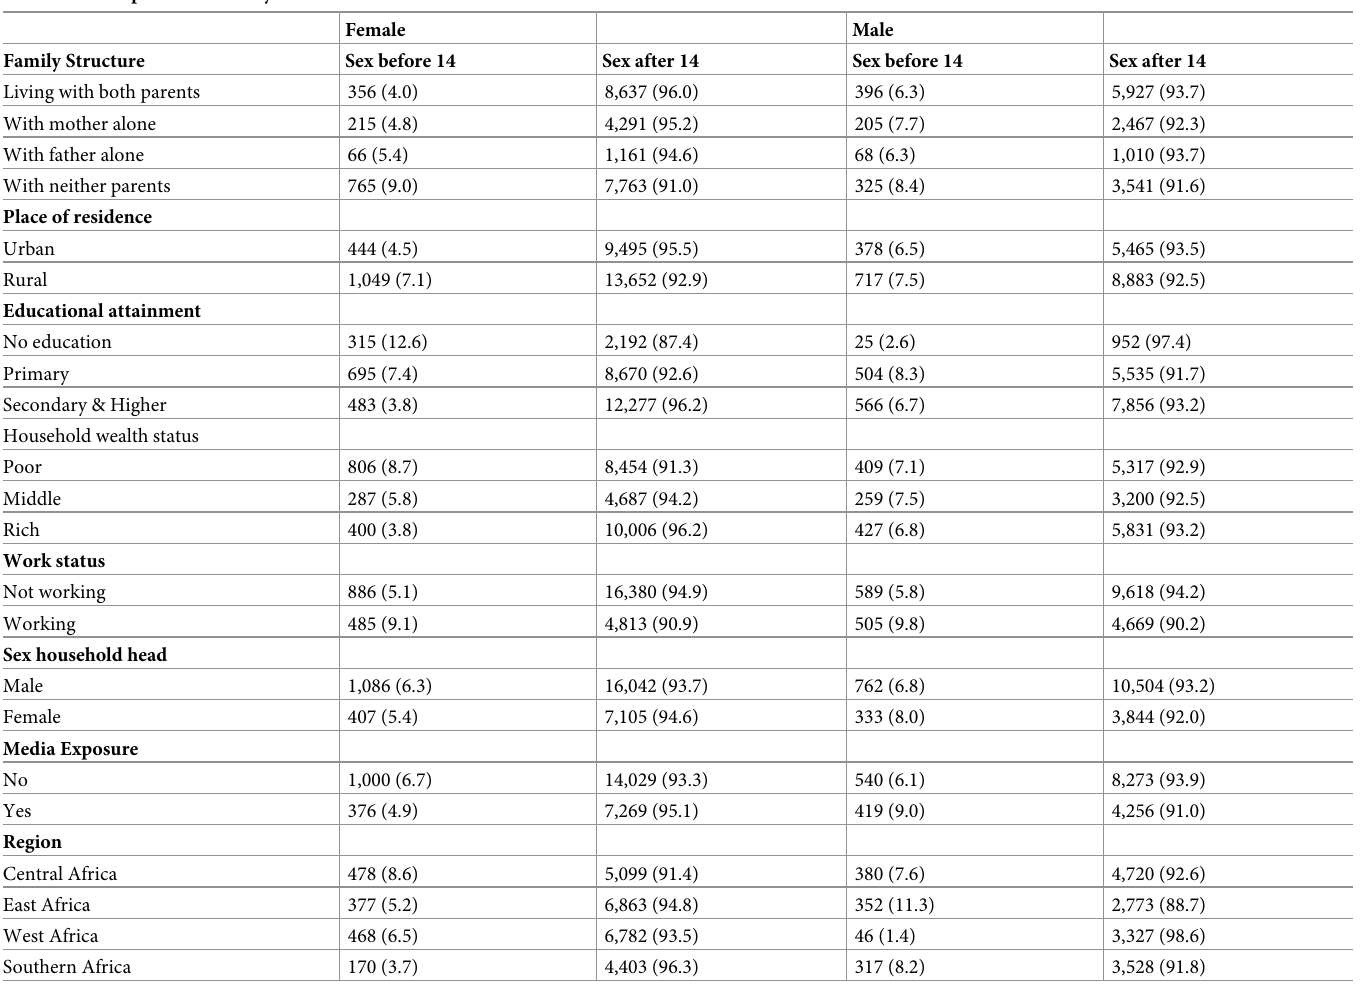
Table 1. Descriptive statistics by sexual